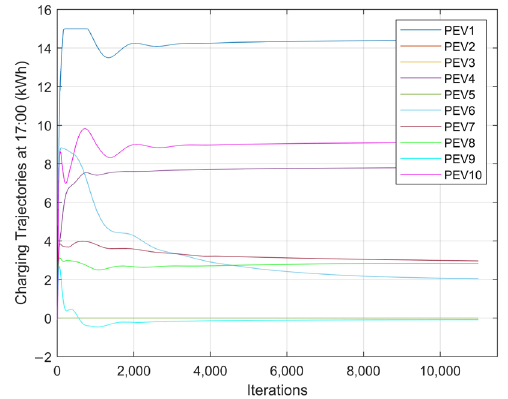
Figure 6. Charging trajectories of all PEVs at 17:00. Table 2. Comparison of the two algorithms.